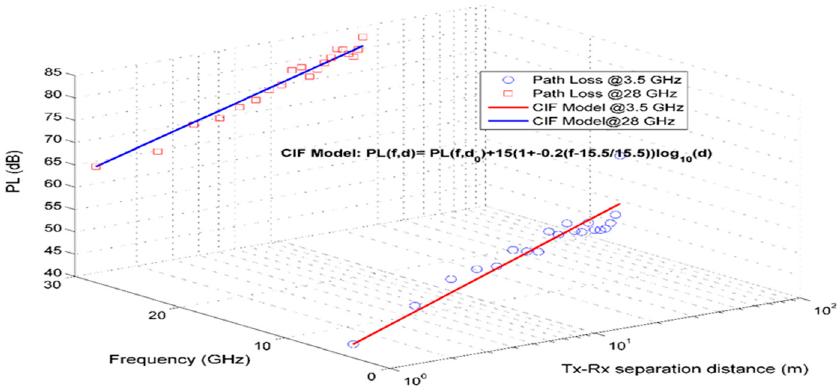
Figure 7. CIF path loss model versus Tx-Rx separation distance for LOS scenario.